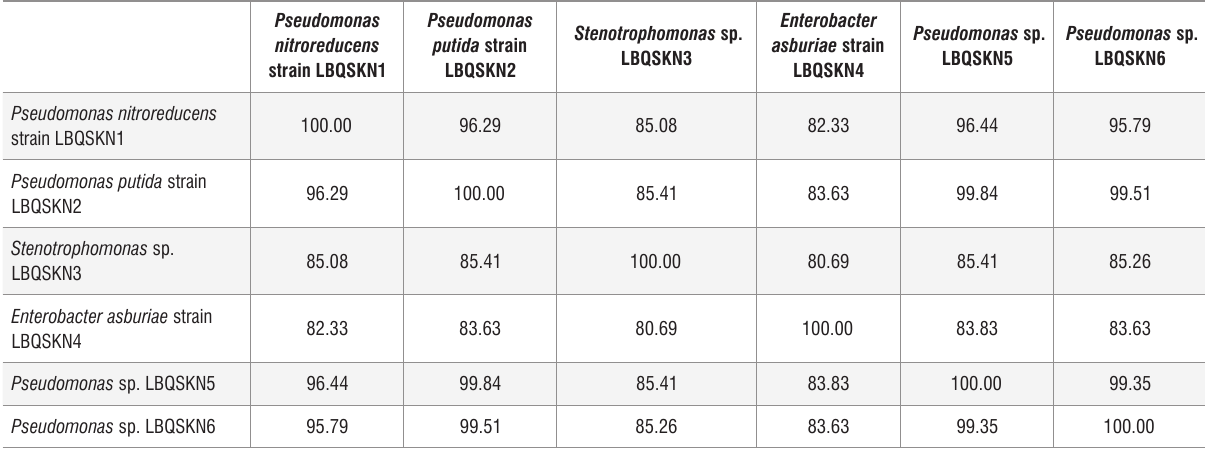
Homology (percentage identity) analysis of 16S rRNA gene sequences of bacterial